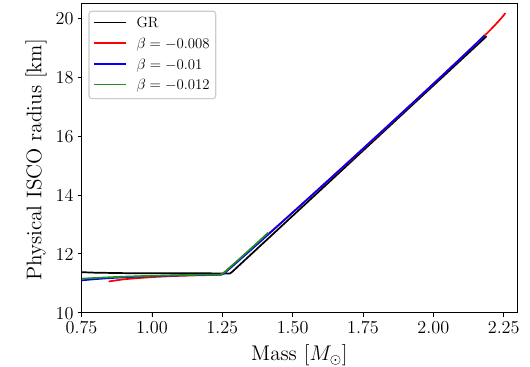
Fig. 11 Maximum absolute value of the radial epicyclic frequency ν r as a function of the gravitational mass for GR and TMST with the monotonic coupling function (12), for n = 1, different β values and f = 0